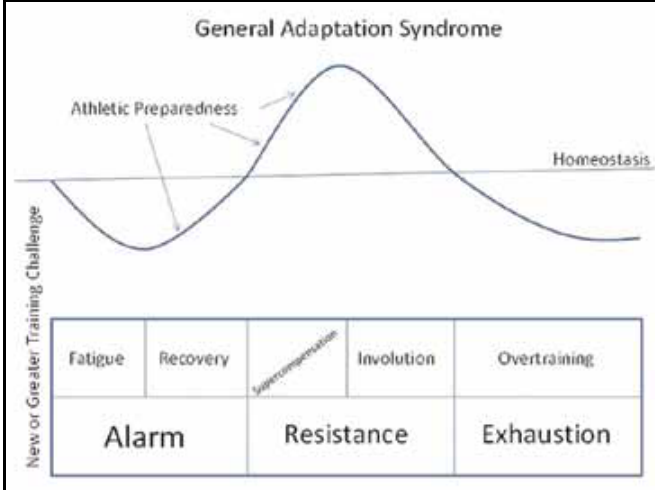
Figure 2-1. Selye’s General Adaptation Syndrome